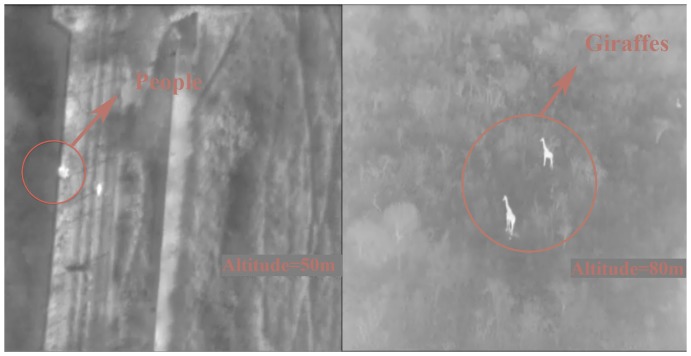
Frames extracted from thermal video camera.Left: A person near the fence (medium quality image). Right: two giraffes captured during one of the flights. Although giraffes were not the targets of our study, this image may serve as an example of the quality of thermal captures when thermal contrast is high.